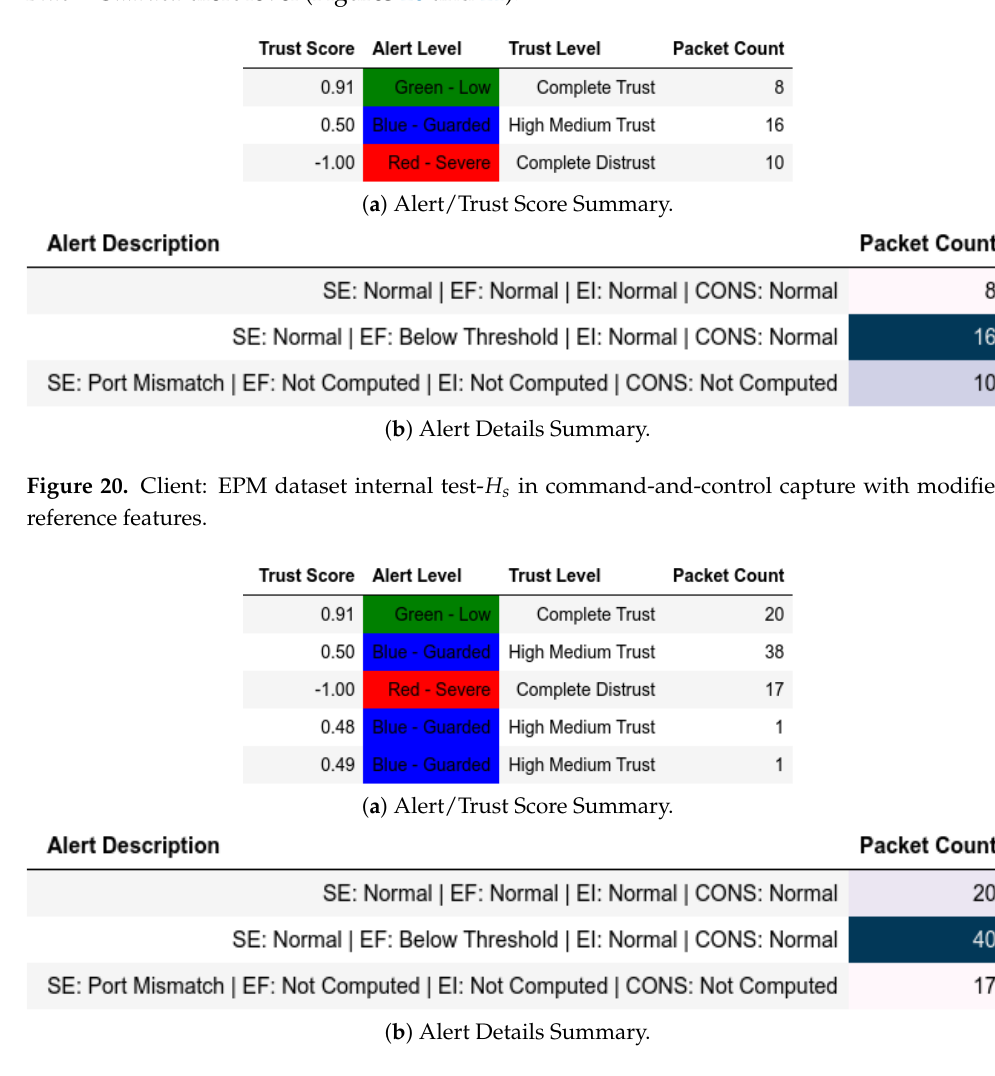
Figure 21. Client: EPM dataset internal test- H s in moving files capture with modified reference